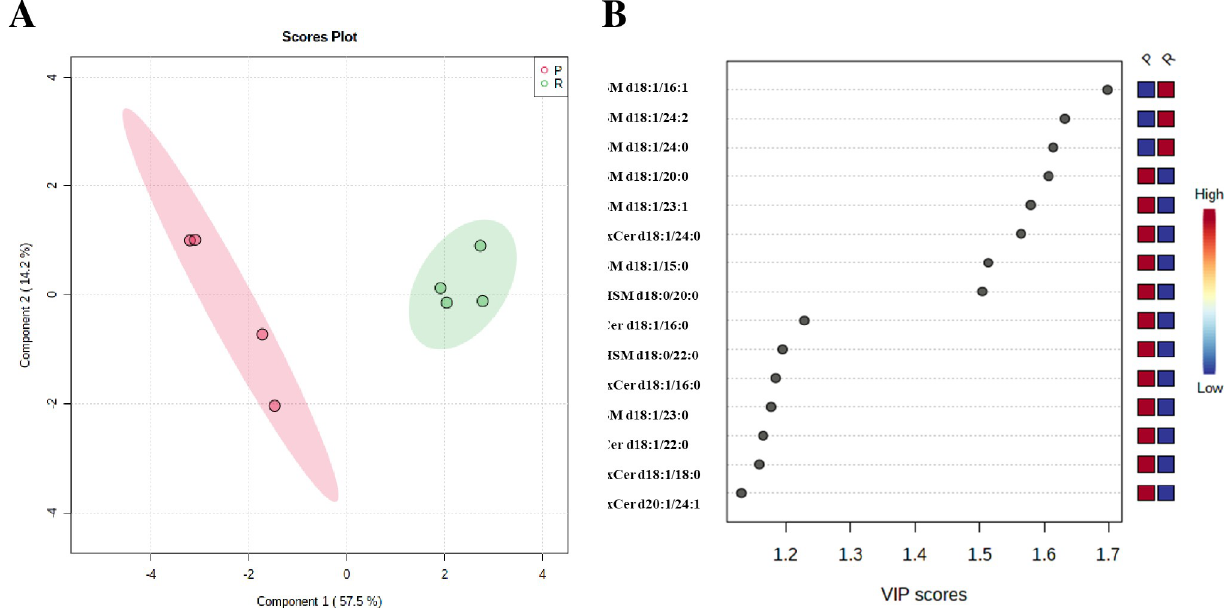
Fig 3. PLS-DA model for biomarker identification and selection. ( A ) 2D score plot for parental and dox-resistant MCF-7 cells. The red color indicated parental MCF-7, and green indicated dox-resistant MCF-7. ( B ) VIP score plot for parental and dox-resistant MCF-7 cells.